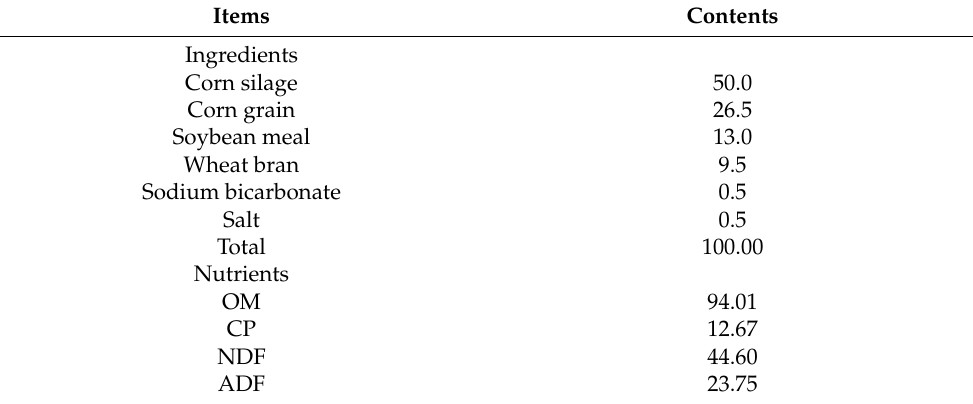
Table 2. Ingredients and nutritional composition of experimental ration (%